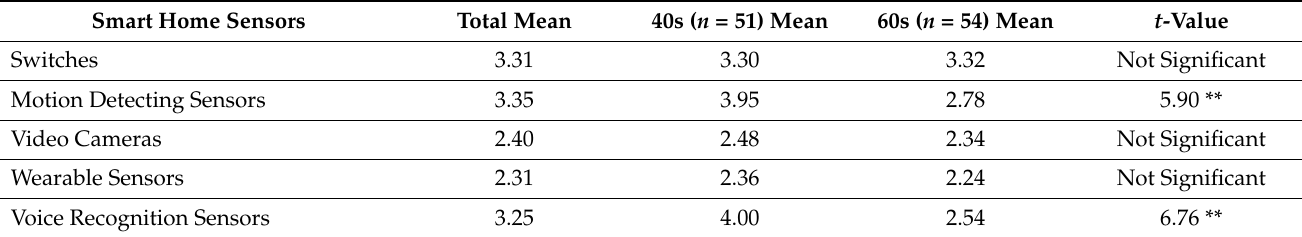
Table 7. Smart Home Sensor Preference by Age Group (** p < 0.001).